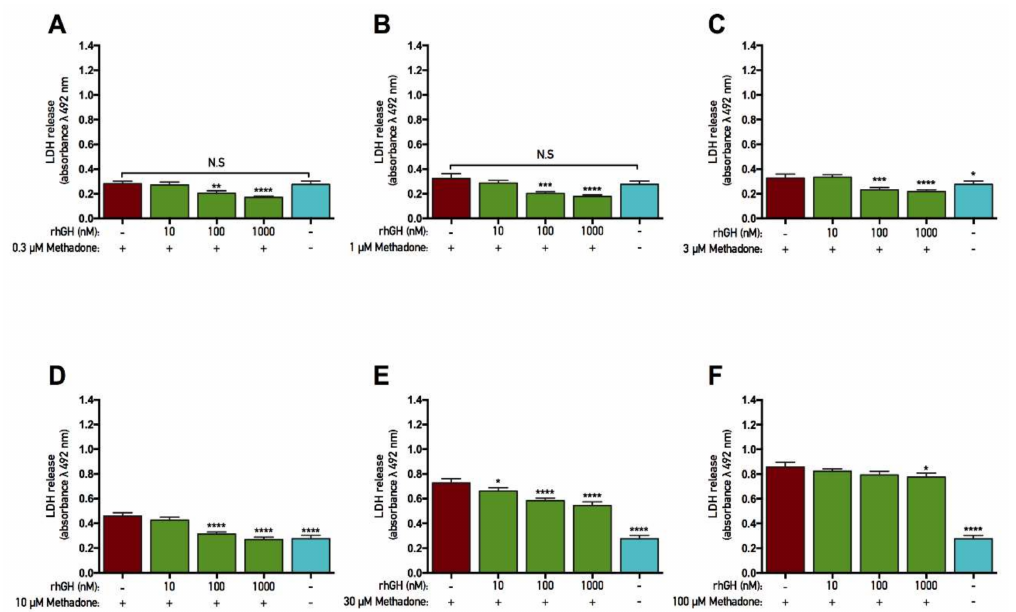
Figure 2. Recombinant human growth hormone protects against methadone-induced membrane damage. Membrane integrity was assessed by lactate dehydrogenase (LDH) assay. Recombinant human growth hormone (rhGH) was added with methadone for three consecutive days prior to analysis. ( A ) Effects of 0.3 µ M methadone with or without 10–1000 nM rhGH. No significant